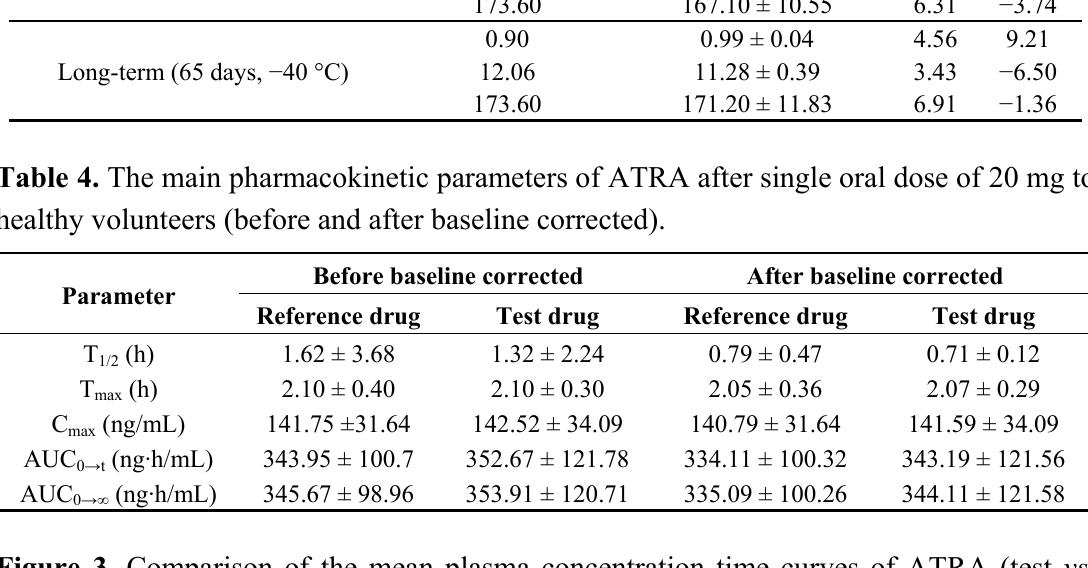
Figure 3. Comparison of the mean plasma concentration time curves of ATRA (test vs . reference) from 29 volunteers after baseline